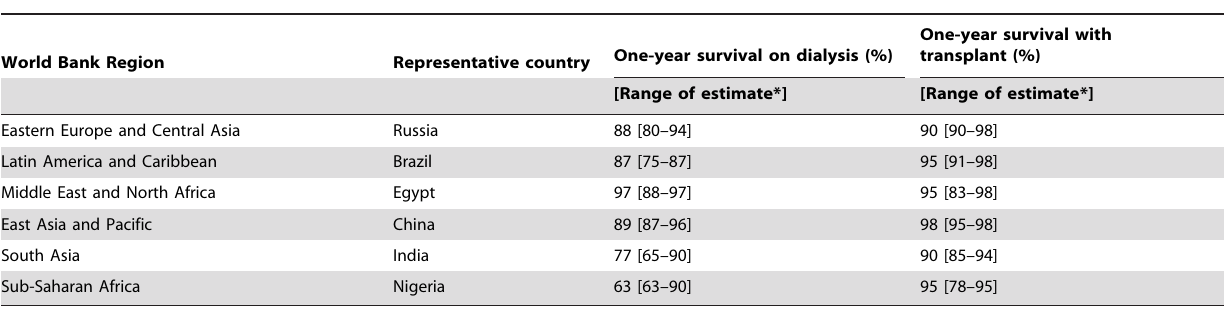
Table 3. Estimates of first-year survival on renal replacement therapy.